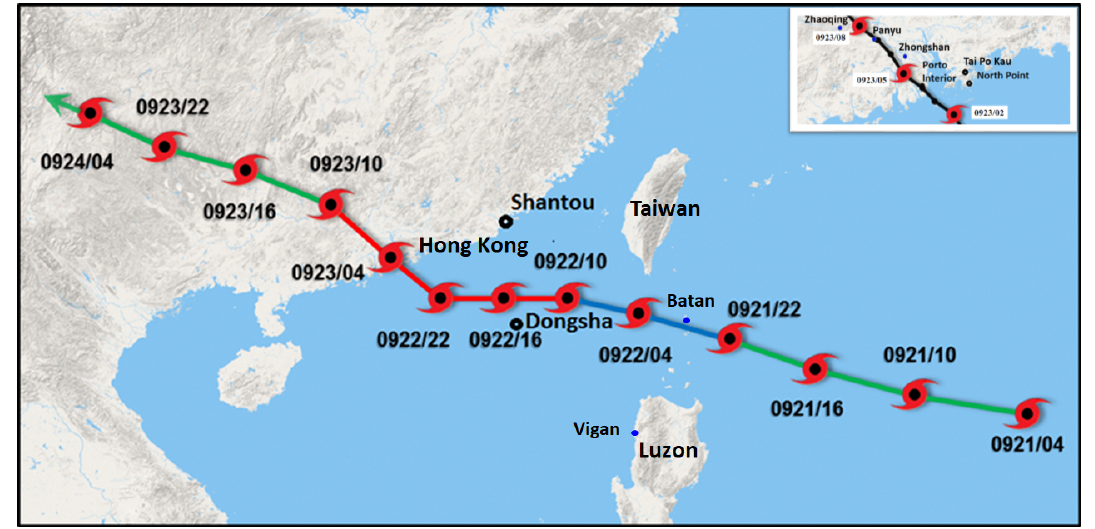
Figure 6. Geographical map (© OpenStreetMap contributors 2019; distributed under a Creative Commons BY-SA License) showing the possible track of Typhoon 1874 passing through the Luzon Strait between Taiwan and Luzon and moving across the northern part of the South China Sea reconstructed in this study. The locations of Shantou, Dongsha, Vigan, and Batan are also shown. The small figure at the upper right corner shows the part of the possible track of Typhoon 1874 before and after making landfall at the Pearl River Estuary as well as the locations of the tide gauges at North Point and Tai Po Kau in Hong Kong and Porto Interior in Macao, along with the locations of Zhongshan, Panyu, and Zhaoqing in western